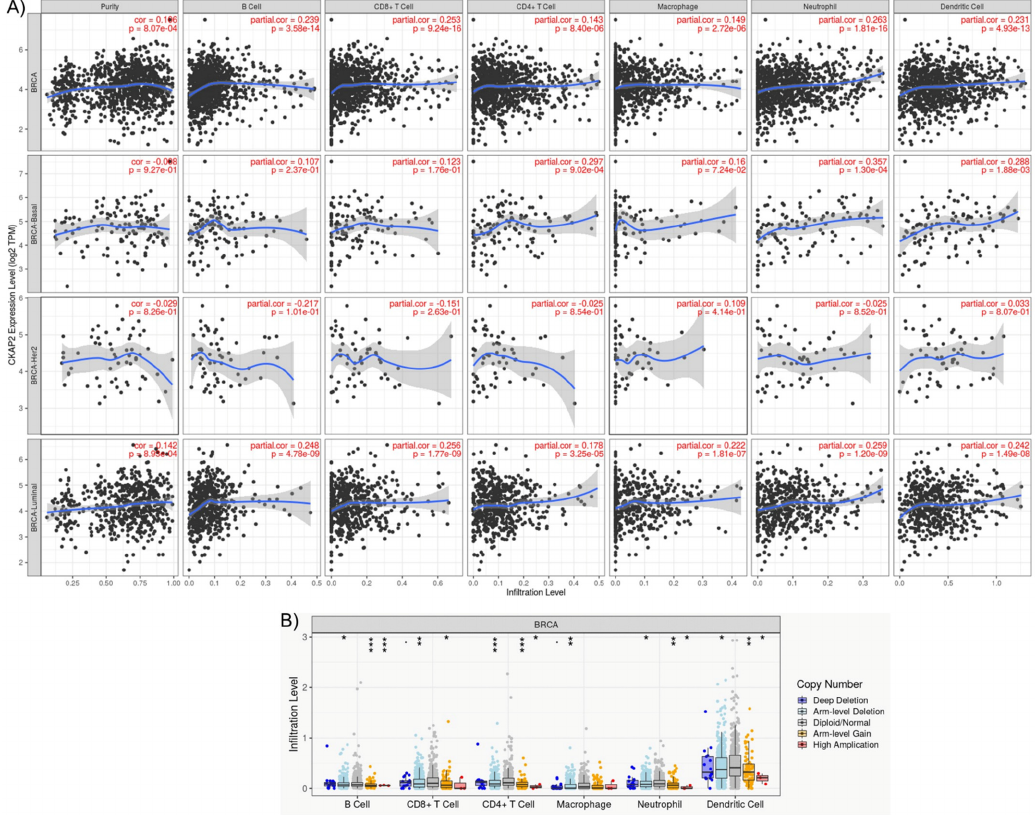
Figure 6. The TIMER analysis results. ( A ) Relationships between CKAP2 expression and immune infiltration levels of B cell, CD8+ T cells, CD4+ T cells, dendritic cells, macrophages, and neutrophils in breast cancer according to TIMER2.0. ( B ) The correlation between somatic copy number alterations (SCAN) and abundance of immune infiltrates of CKAP2 , including deep deletion, shallow deletion, diploid/normal, low-level gain, and high amplification.